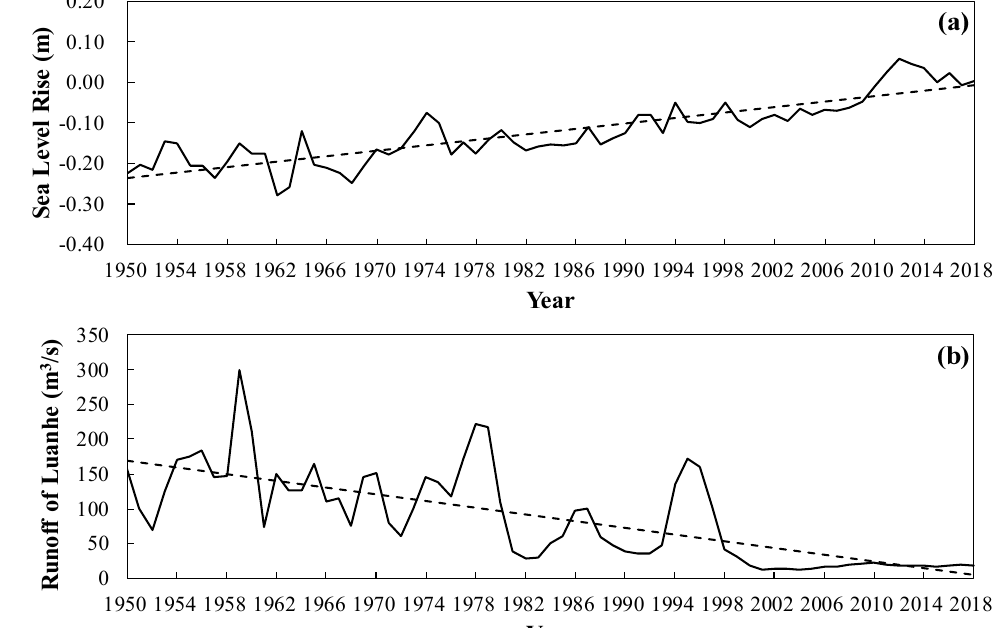
Figure 3. ( a ) Variation of sea level at the Tanggu station in Bohai from 1950 to 2018; ( b ) Runoff discharge in Luanhe River at Luanxian station from 1950 to 2018.